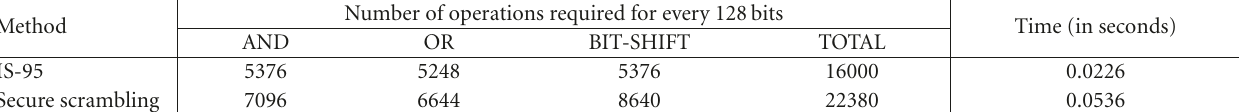
Table 1: Complexity comparison of the two generation methods of long scrambling sequences.